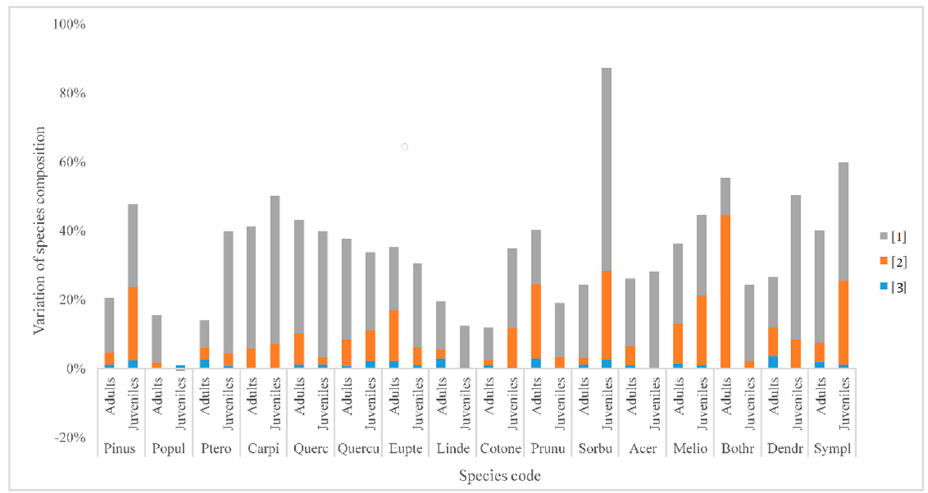
Figure 6. The variance explained by topographic and spatial variables for the each species at different life stages in the 25-ha permanent forest dynamics plot in the Qinling Mountains, north-central China. See Table 1 for species code. [1], purely spatial fraction [c]; [2], spatially structured topographic fraction [b]; [3], purely topographic fraction [a].